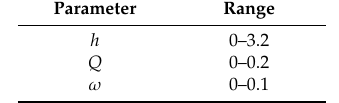
Table 1. Parameters and their ranges considered for the sensitivity analysis.